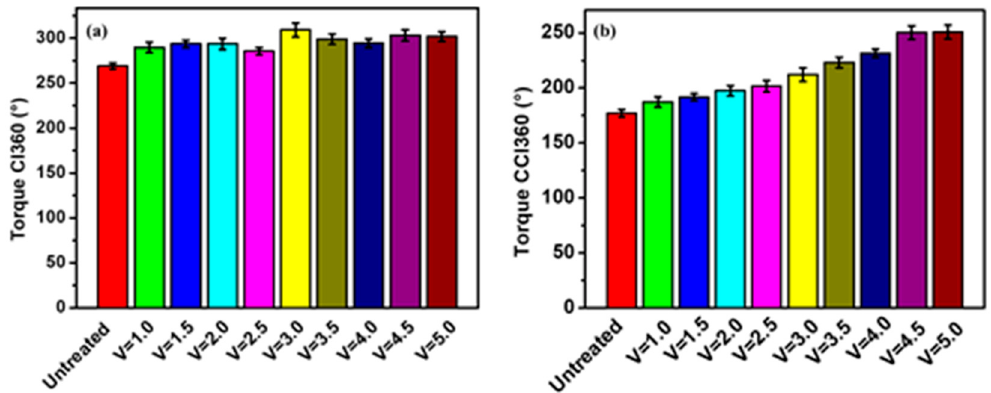
Figure 8. Rotation angle of braid-reinforced composite hollow fiber tube with coated and uncoated stainless steel wire: ( a ) clockwise angle, ( b ) counterclockwise angle.